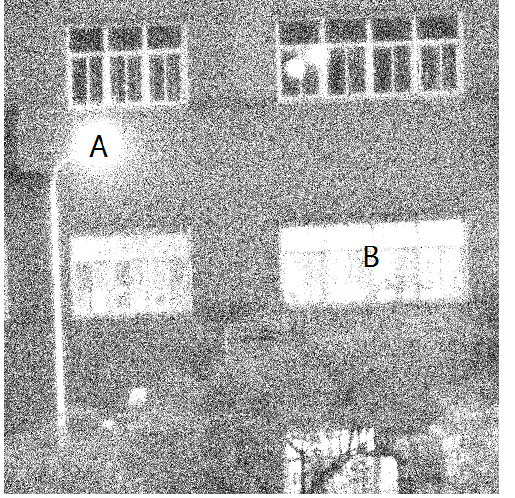
Figure 2. CMOS imaging under extremely low light conditions, 10 lux, 500 × 500 pixels